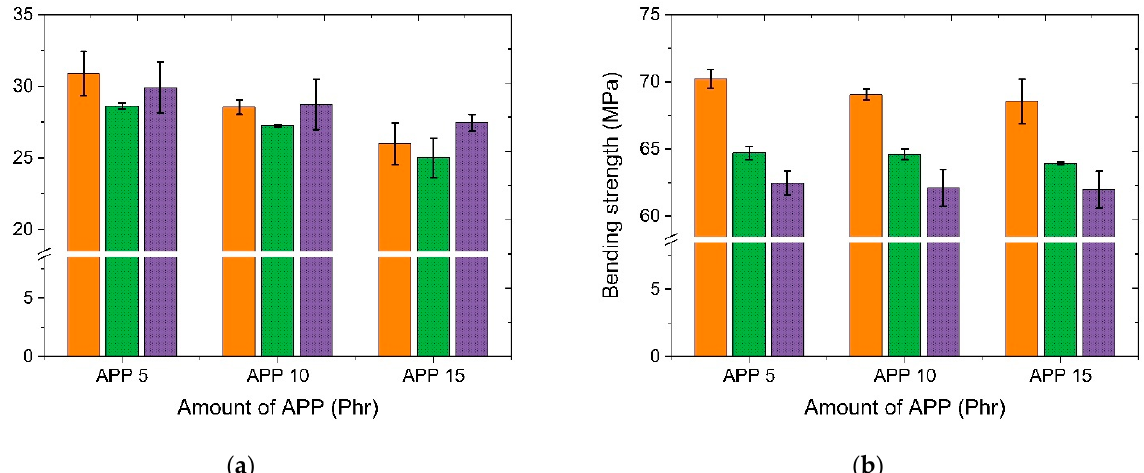
Figure 9. Comparison of physical properties as a function of the addition amount of APP flame retardant and modified flame retardants: ( a ) tensile strength; ( b ) hardness.